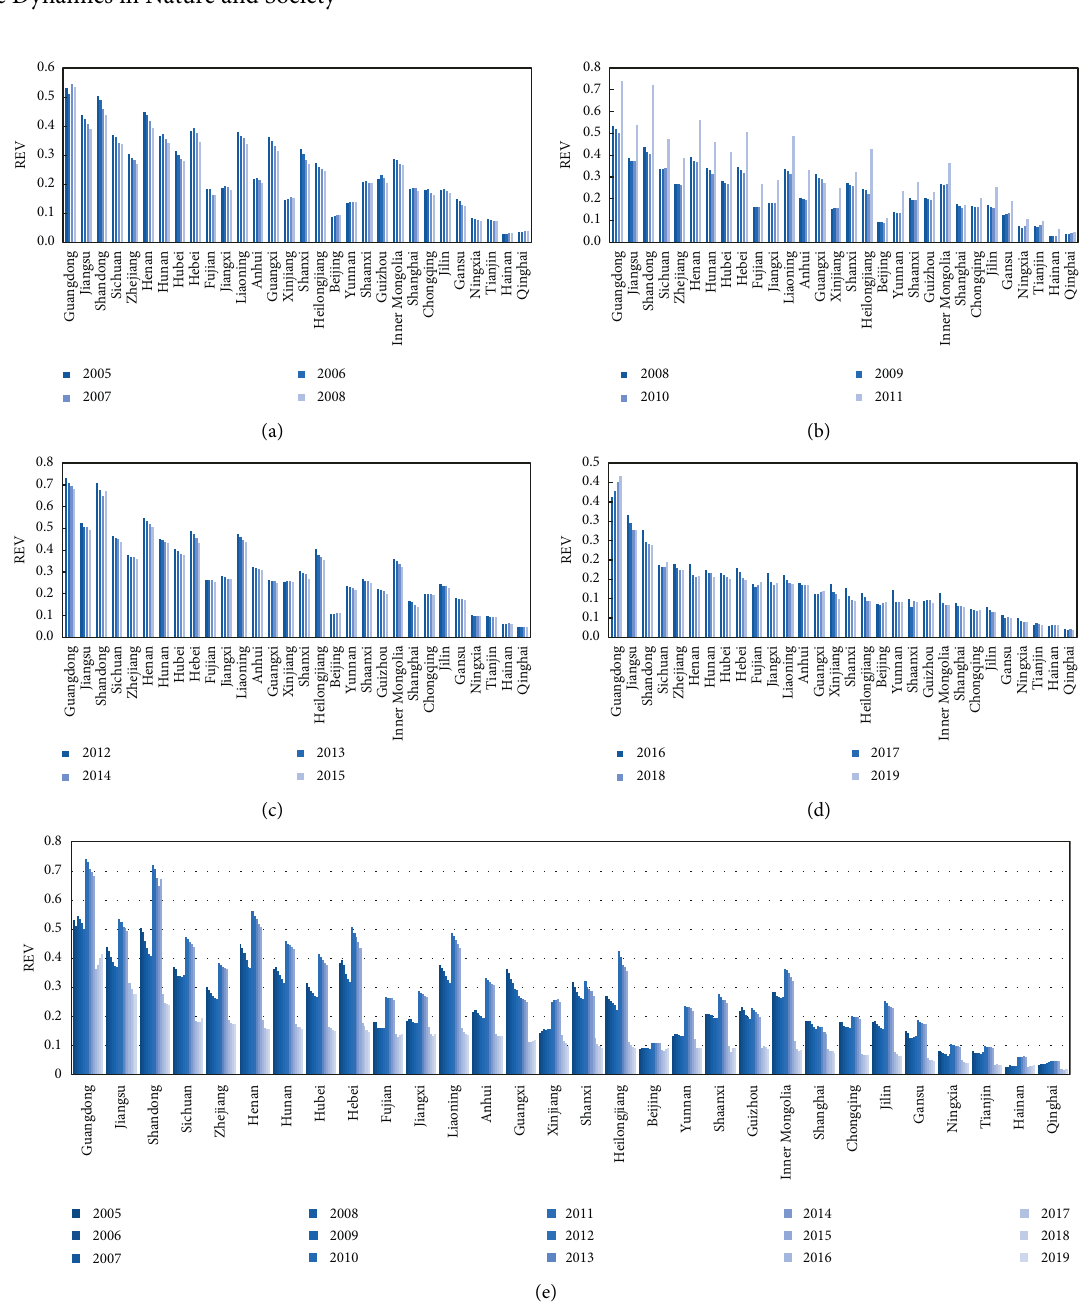
Figure 5: China’s EEE subsystem-REV comparison (2005 ∼ 2019).